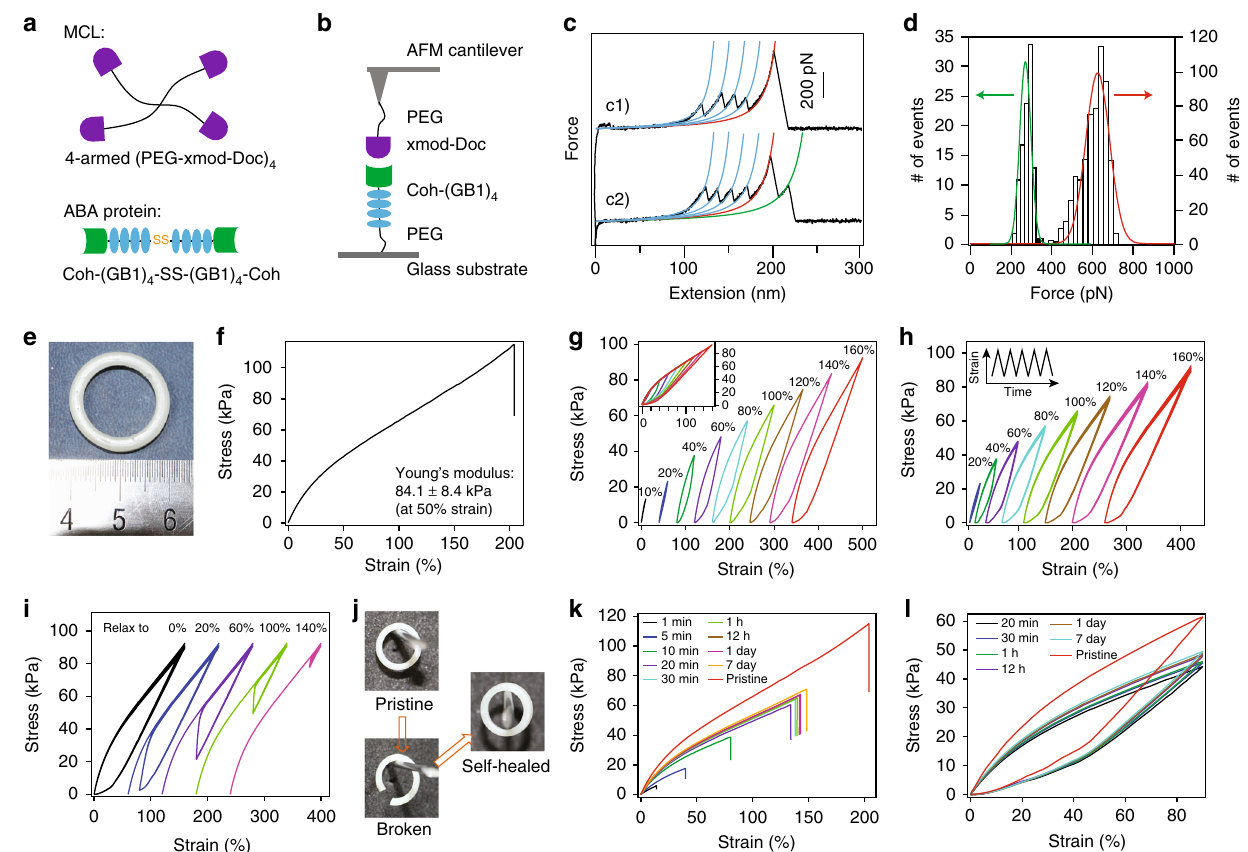
Fig. 5 Rationally designed self-healable muscle-mimetic hydrogel (Gel-4). a Schematic of the building blocks for the hydrogel network. b The mechanical properties of the minimum unit in the hydrogel stretched by single-molecule AFM. c Two representative force curves. Sawtooth-like patterns with unfolding forces of ~180 pN correspond to the unfolding of GB1 domains. The rupture of the Xmod-Doc:Coh could either result in a single peak with a force ~600 pN (c1, accounts for 40% of total events) or double peaks with forces of ~600 and ~300 pN, respectively (c2, accounts for 60% of total events). d The rupture force histograms for the two types of rupture events of the Xmod-Doc:Coh complex. The higher force events for both types of traces are the same and are centered at ~600 pN, which de fi nes the mechanical properties of the Xmod-doc:Coh complex. The lower force histogram for the double-peak events centers at ~300 pN, which is also higher than the unfolding forces of GB1. e Photo of the hydrogel ring. f The stress – strain curves of the muscle- mimic hydrogel until break. g The stretching – relaxation curves of the hydrogel when being stretched to different strains. The curves are horizontally offset for clarity. The fi nal strains are shown on the curves. Insets show the superposition of the stretching – relaxation curves at different strains. h Five continuous stretching – relaxation cycles of the hydrogel (Gel-4) to different strains without any waiting time between each cycle. The inset shows the change of strain with time in the cycles. Only minute mechanical fatigue of muscle-mimic hydrogels was observed. i The stress – relaxation curves of the hydrogel when fi rst being stretched to a strain of 160% and then immediately relaxed to different strains and stretched back for 5 repetitive cycles. j Photos of the pristine, broken and self-healed hydrogels hanging on a peg. k The recovery of the mechanical properties of the hydrogel after different self-healing times. l The stretching – relaxation curves of self-healed hydrogels with different healing